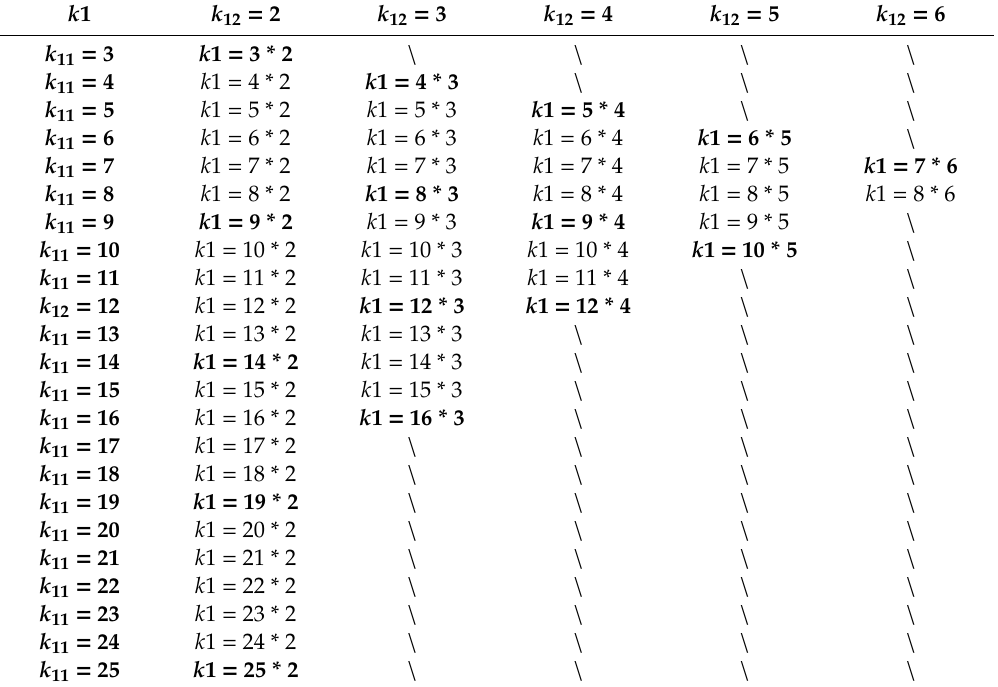
Table 4. Di ff erent values of k 1.